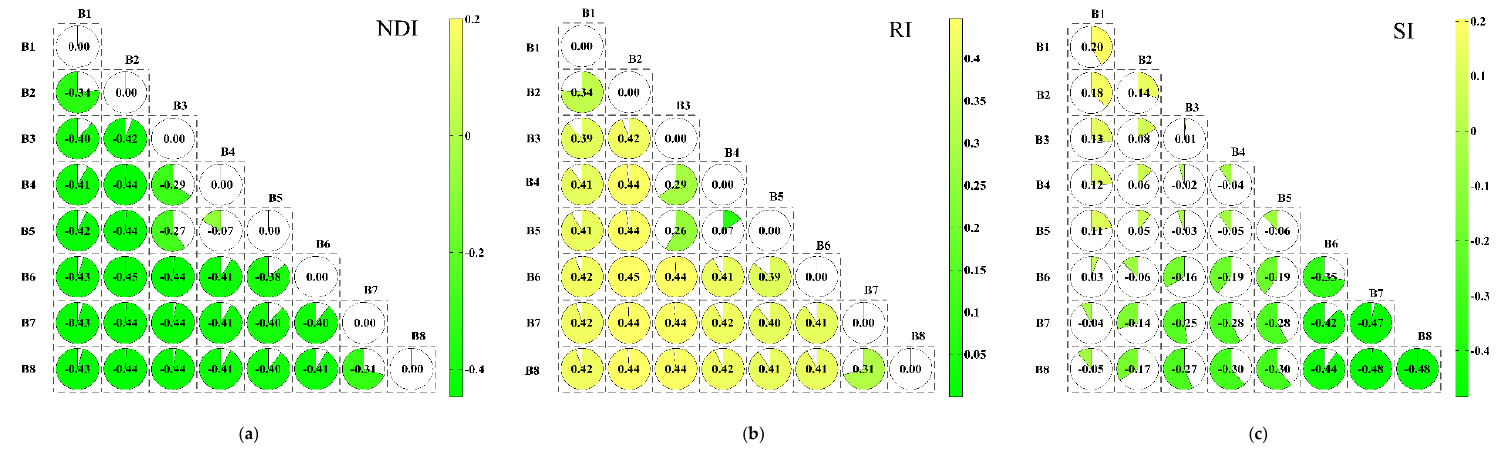
Figure 8. The correlation analysis between EC and optimized spectral indices based on square data (R-SQ). ( a – c ) represent the correlation EC with NDI, RI, and SI,